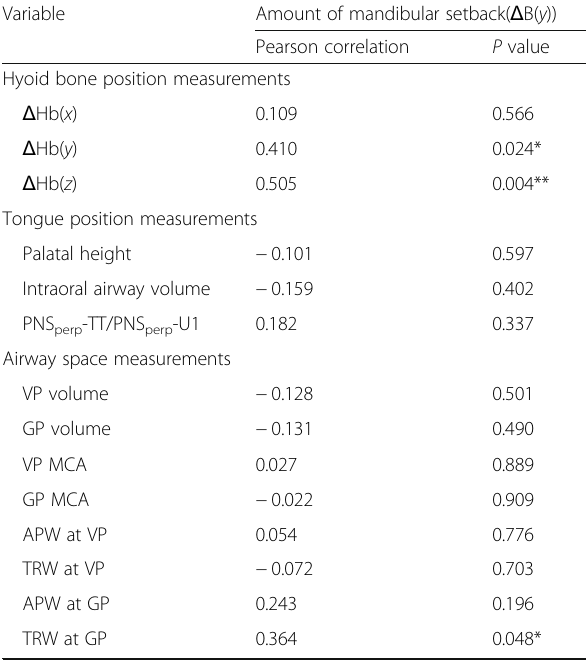
Table 6 Correlations between the amount of mandibular setback and the changes of the variables